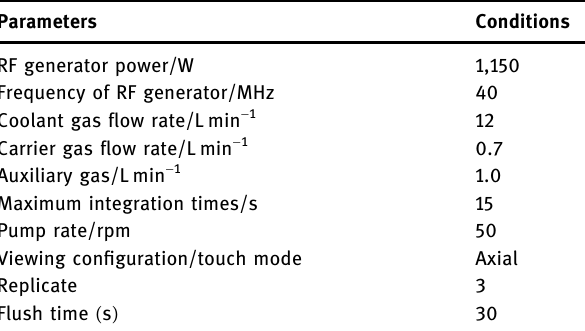
Table 1: Operating parameters of ICP - OES